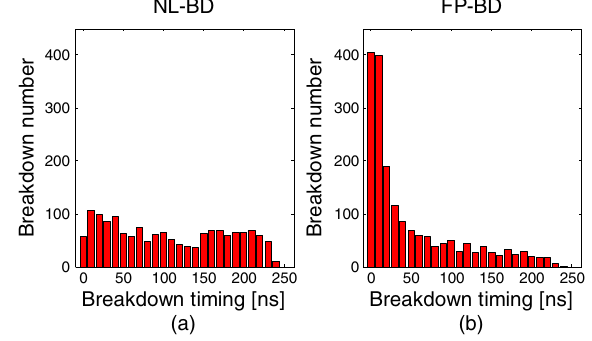
FIG. 10. Breakdown timing distribution in 252 ns pulse operated at 252 ns operation. (a) Statistics of 1561 NL-BD events. (b) Statistics of 1859 FP-BD events.